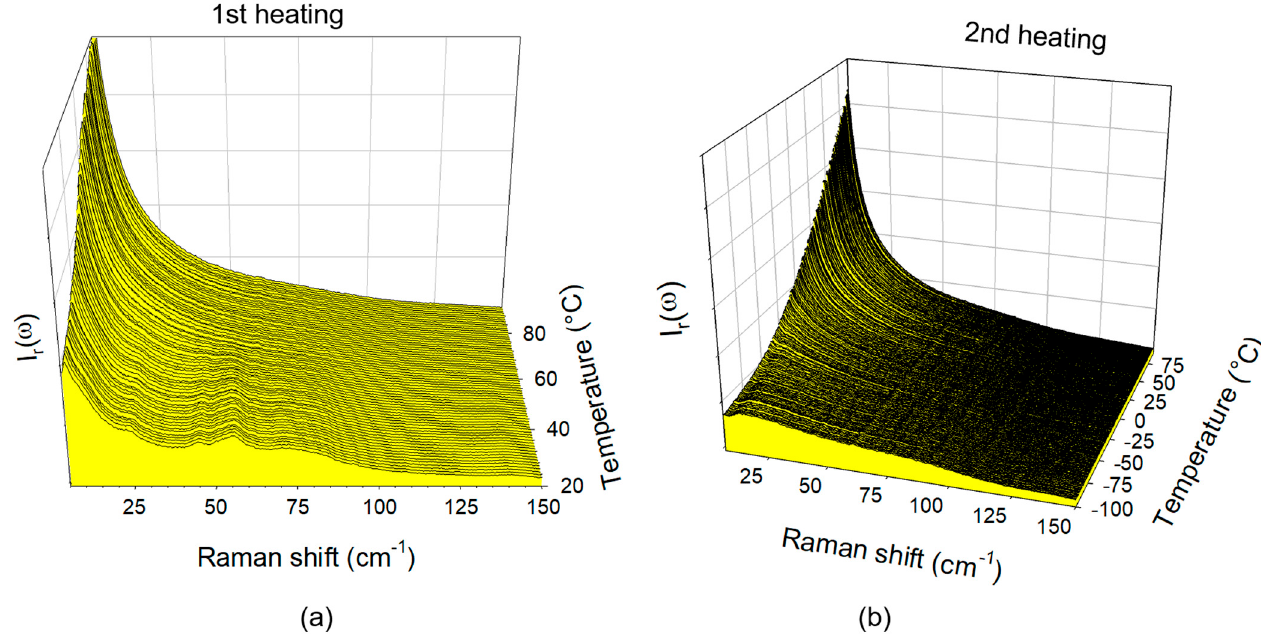
Figure 5. Low-frequency Raman spectra of the composite (IBP35%:SBA-15) prepared by MAL at 10 Hz collected upon heating at 1 °C/min; ( a ) first heating from room temperature up to 100 °C of the composite freshly prepared; ( b ) second heating of the composite from − 100 °C .